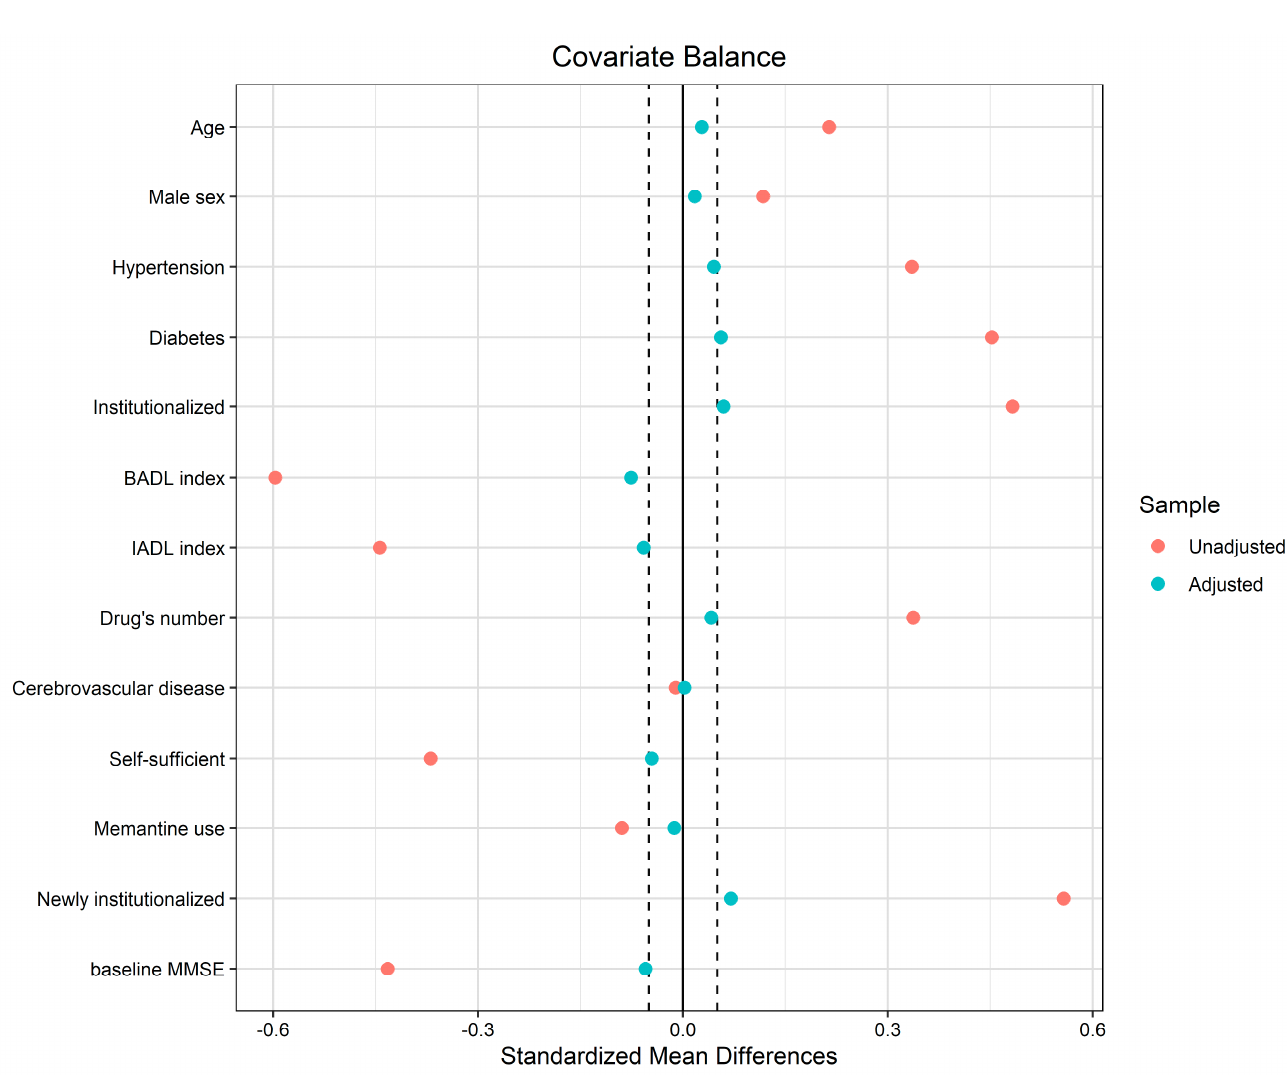
Figure 2. Graph of covariate balance before (unadjusted pink points) and after (adjusted cyan points) weighting variables using the propensity score model. For continuous variables, the standardized mean difference is reported, whereas, for binary variables, the raw mean difference is reported. Dark vertical dashed lines were plotted at ±0.05 from zero difference as a measure of significance. Table 3. Predictors of COVID-19 and significant cognitive decline in univariate Cox proportional hazards analysis.